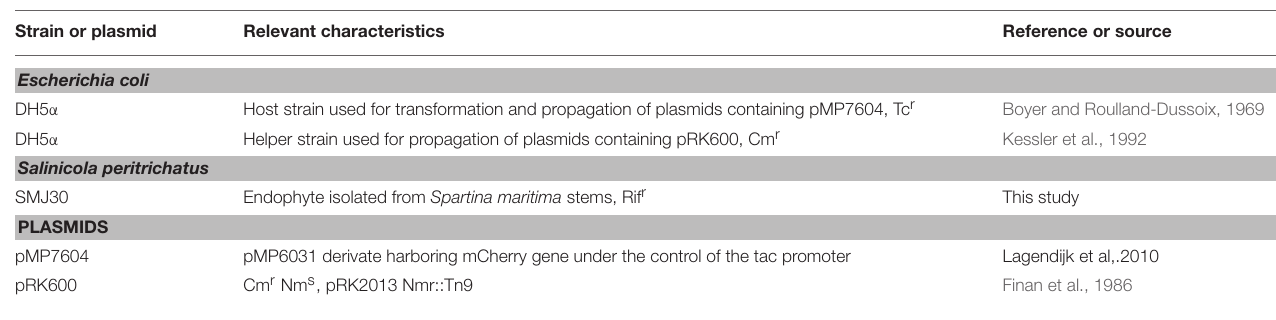
TABLE 3 | Strains and plasmids used for bacterial